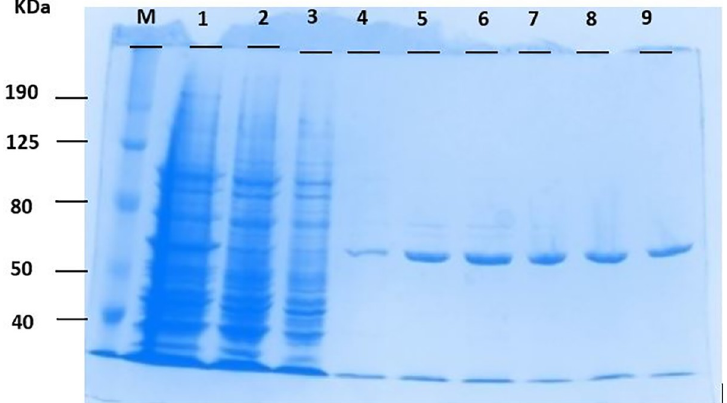
Fig 6. SDS-PAGE of the recombinant ATII-TrxR protein. Aliquots from the HisTag purification process of the ATII-TrxR protein from total bacterial proteins were analysed by 10% SDS-PAGE as described in the experimental procedures. M: molecular weight marker; lane 1: induced sample along with all bacterial proteins; lanes 2 & 3: bacterial flow-through-1 & flow-through-2; lanes 4–9: different fractions of eluted and purified ATII-TrxR protein with a size of 57.8